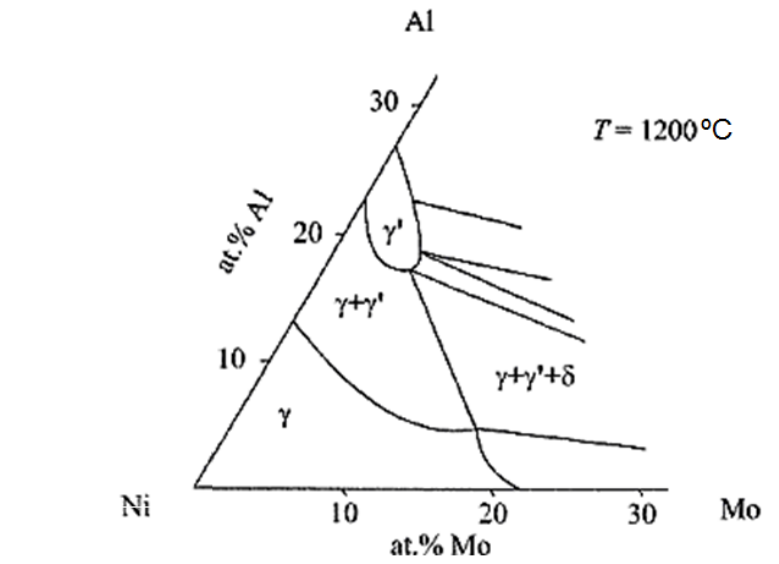
Figure 1 – Part of the Ni-rich Ni-Al-Mo phase diagram at 1200 ºC (Miracle et al, 1984,